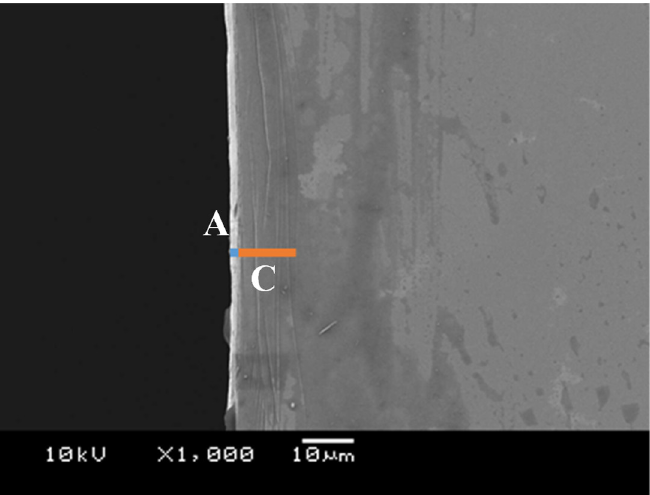
Figure 8. Microstructure damages of electrical amorphous steel sheet induced by piercing in a single shot with the use of the diamond-coated punch.